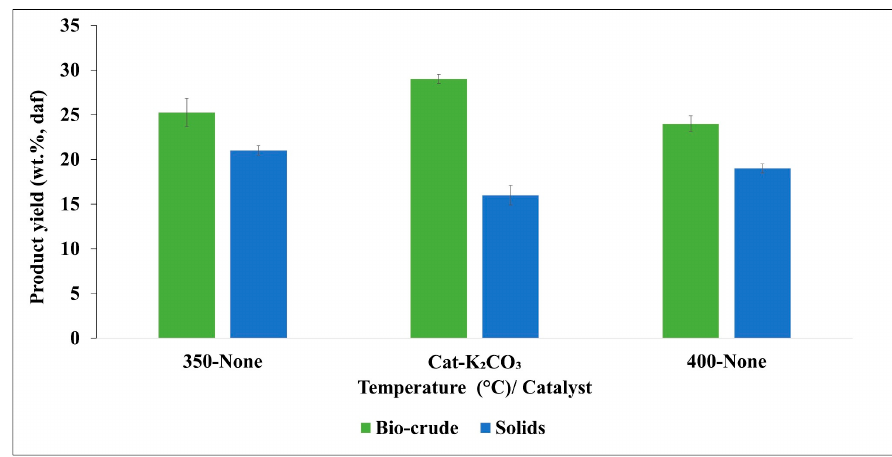
Figure 3. Product yield at sub and supercritical conditions.